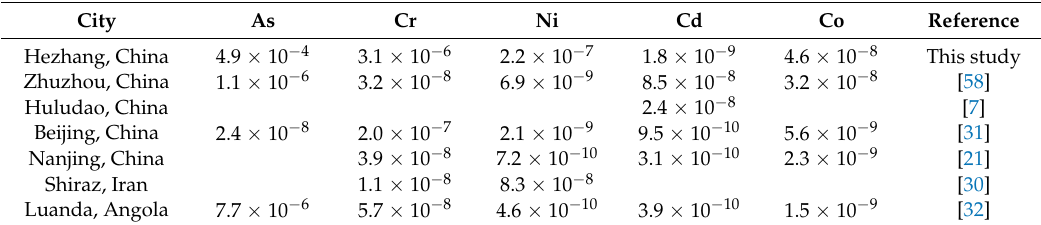
Table 10. Comparisons of cancer risk in street dust of different